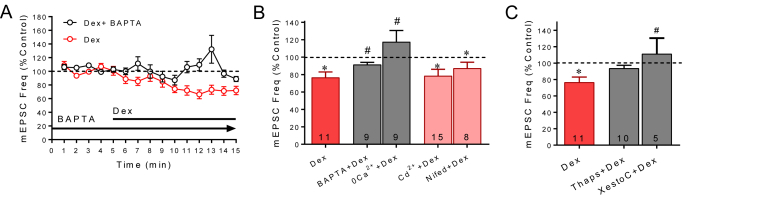
Glucocorticoid-induced suppression of excitation requires postsynaptic calcium mobilization. A. Running time histogram of the effect on mEPSC frequency of Dex with and without BAPTA in the patch electrode. The Dex-induced decrease in mEPSC frequency was blocked with BAPTA in the electrode. B. Summary bar graph of the effects of calcium blockers on the Dex-induced decrease in mean normalized mEPSC frequency. Dexamethasone had no effect on the mEPSC frequency following intracellular application of BAPTA or extracellular application of a nominally zero calcium solution (0Ca2+) but retained its suppressive effect on mEPSC frequency in cells treated with the voltage-gated calcium channel blockers cadmium (Cd2+, 200 μM) and nifedipine (Nifed, 10 μM) applied in the perfusion bath. C. Summary bar graph of the effects of blockers of intracellular calcium mobilization. Inhibition of the SERCA intracellular calcium transporter with intracellular thapsigargin application via the patch pipette blocked the Dex-induced suppression of mEPSC's (Thaps, 5 μM). Inhibition of the IP3 receptor antagonist Xestospongin C also blocked the Dex-induced decrease in mEPSC frequency (XestoC). *, p < 0.05 compared to baseline; **, p < 0.01 compared to baseline; #, p < 0.05 vs Dex).